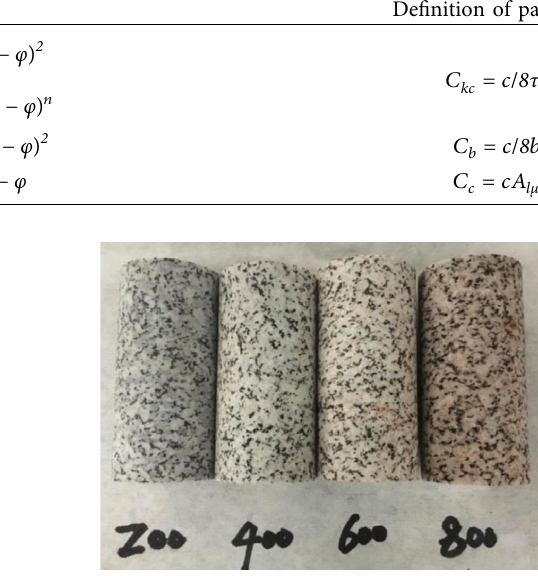
Figure 3: Granite specimens after high-temperature heating